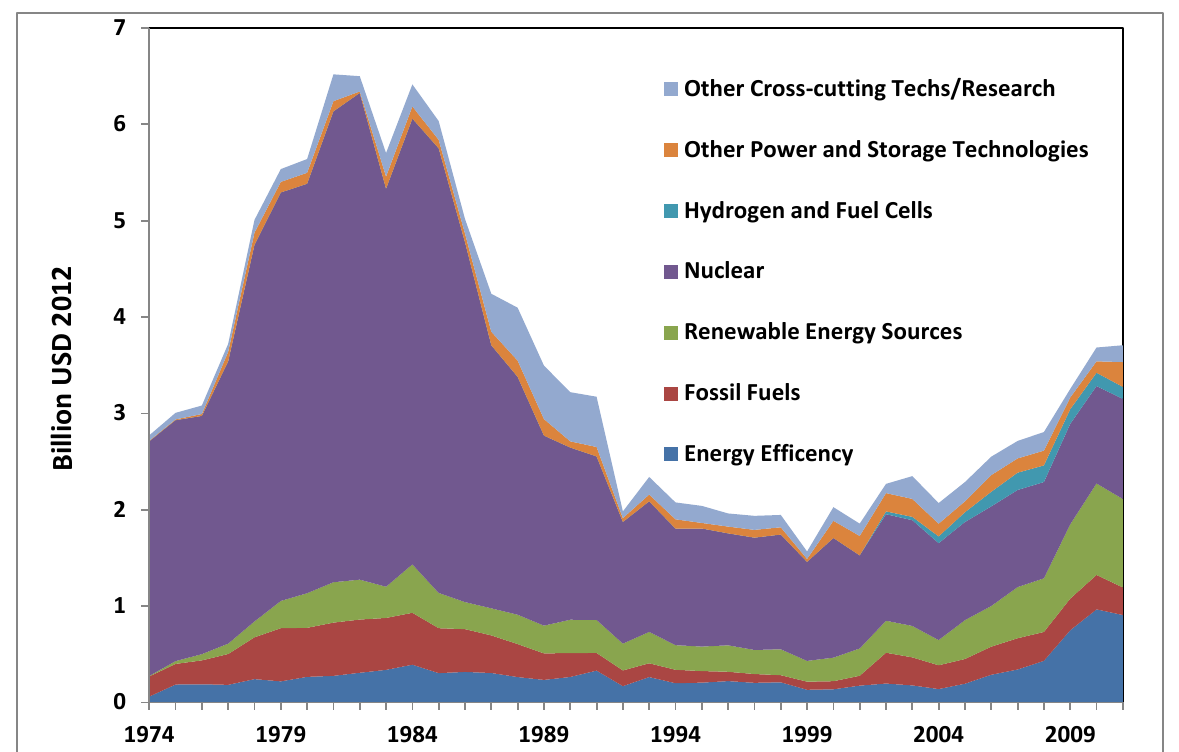
Figure 10. Historic Public Energy Spend by Sector for the major European economies 1974–2011